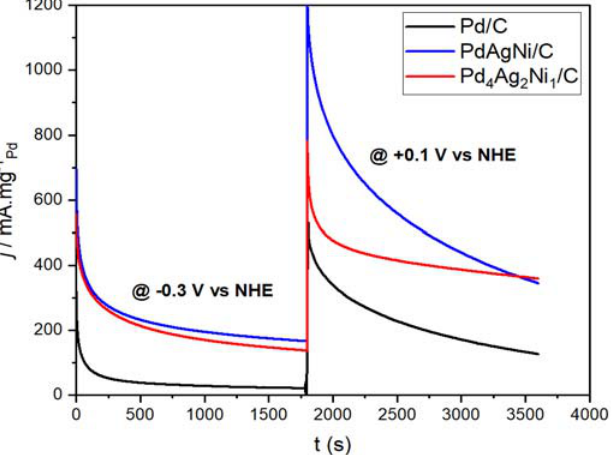
Figure 8. Chronoamperometric (CA) scans of Pd/C, Pd 4 Ag 2 Ni 1 /C, PdAgNi/C at − 0.3 V and +0.1 V vs .